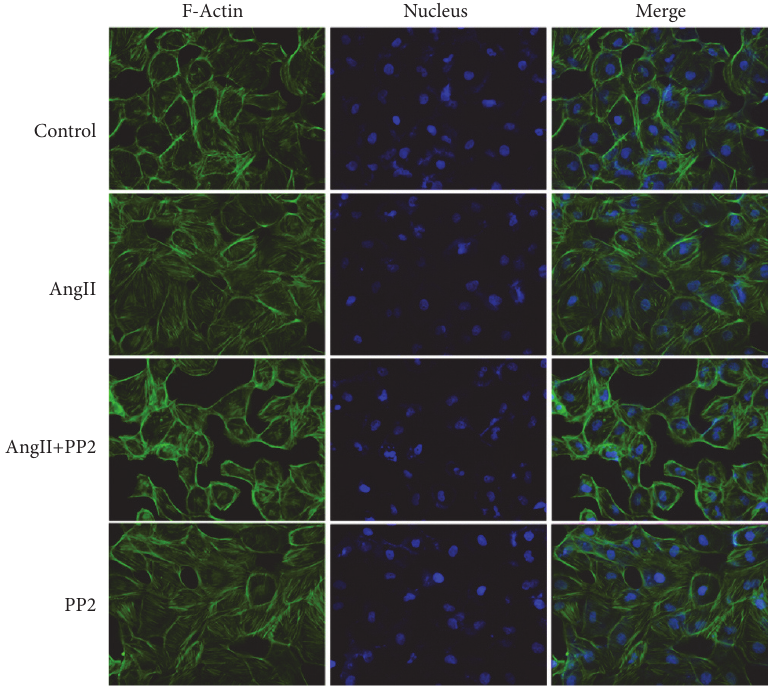
Figure 7: AngII induced skeletal rearrangement in PMVECs through inducing the dephosphorylation of Y685-VE-cadherin. Immunoflu- orescence indicated accumulation of stress fiber in PMVECs after AngII stimulation. In AngII+PP2 group, filopodia were noticed in the PMVECs, together with endothelial shrinkage and increase of intercellular space. The images were observed under a magnification of 400x.